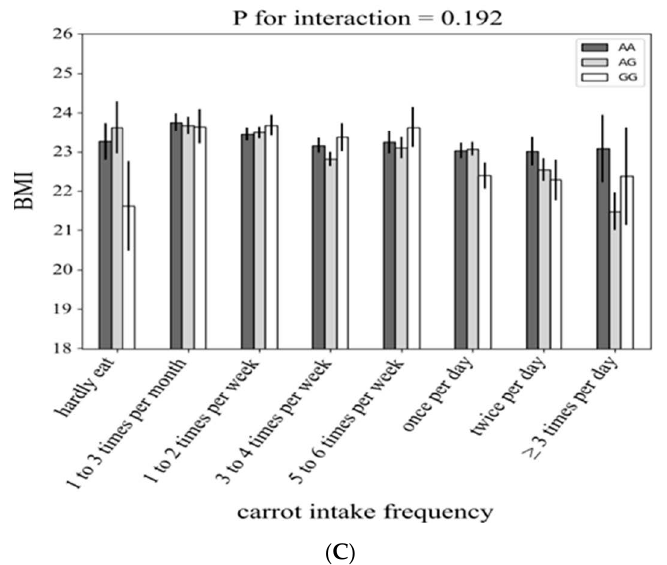
Figure 5: The association between each rs4445711 allele and frequency of carrot intake: subgroup analysis stratified by age. The y -axis represents body mass index according to the genotype of the lead variant at rs4445711—i.e., GG, AG, or AA—and the x -axis shows the 8 categories of carrot intake frequency, ( A ) younger ( ≤ 39 years), ( B ) middle aged (40–59 years), and ( C ) older adult ( ≥ 60 years).